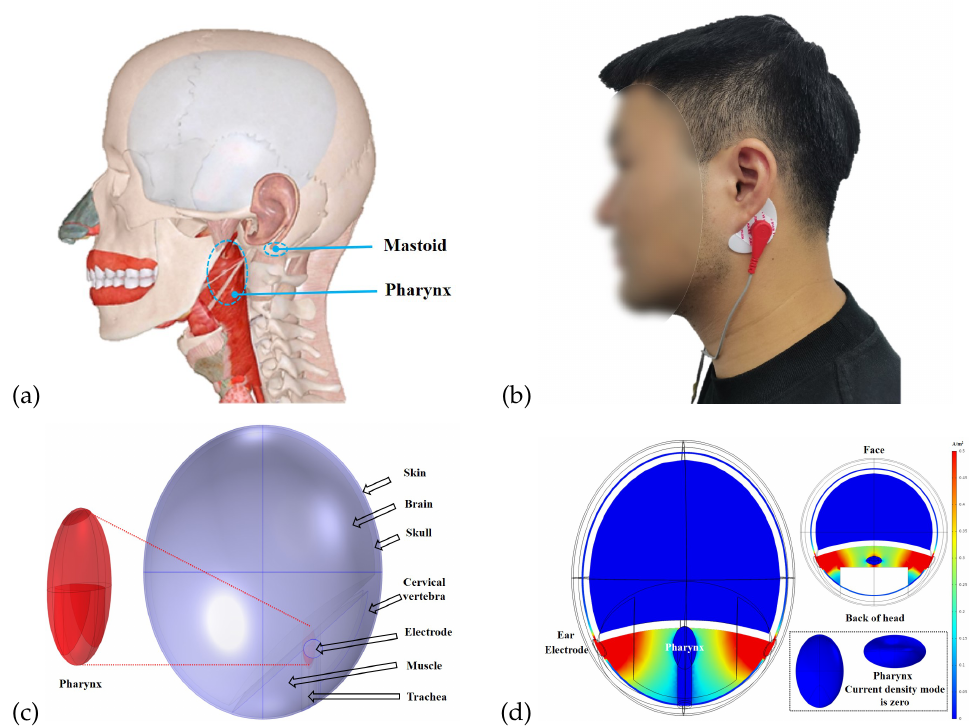
Figure 2. Construction of finite element model. ( a ) Anatomical structure of the head. ( b ) Schematic diagram of electrode adhesion in subjects. ( c ) Equivalent breathing simulation model of the head. ( d ) Head cross-sectional current density mode distribution.